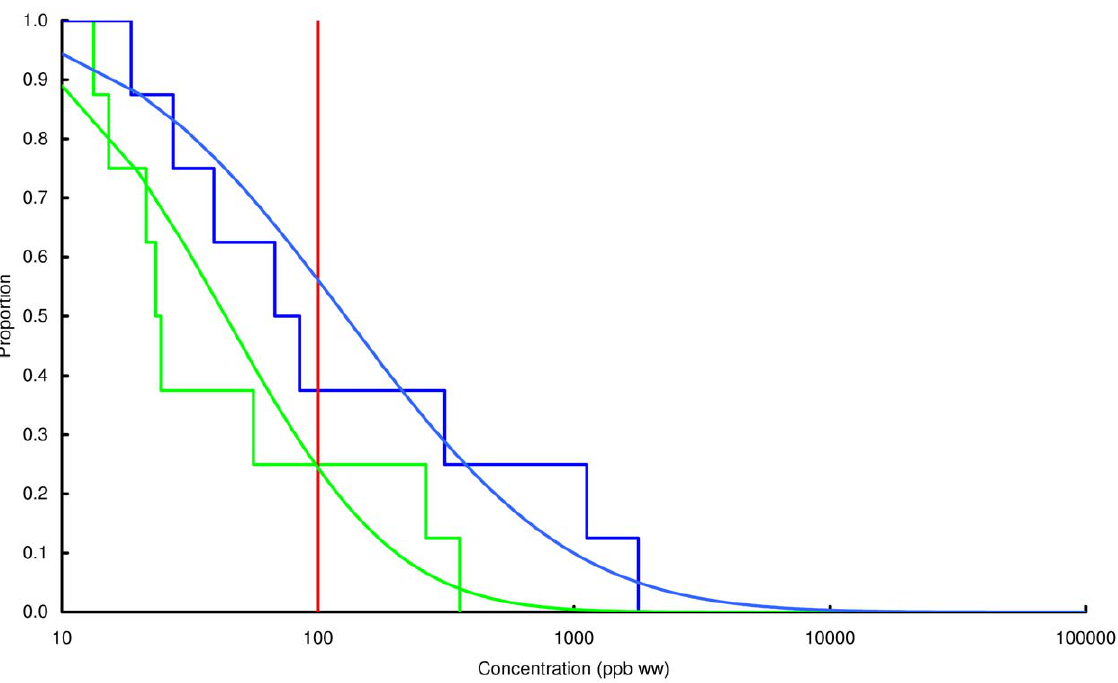
Figure 8. Exceedance distribution of lead concentrations in wild mallard. Observed (stepped line) and fitted (curve) exceedance distribution of lead concentrations (ppb wet weight) in wild mallard cooked using acidic (green) and non-acidic (blue) methods. The curves represent lognormal distributions fitted to all the data, including those below the limit of quantification, by a maximum-likelihood method involving left-censoring at the LOD/LOQ. The red vertical line shows the statutory maximum residue level (MRL) for poultry and other non-game meat.